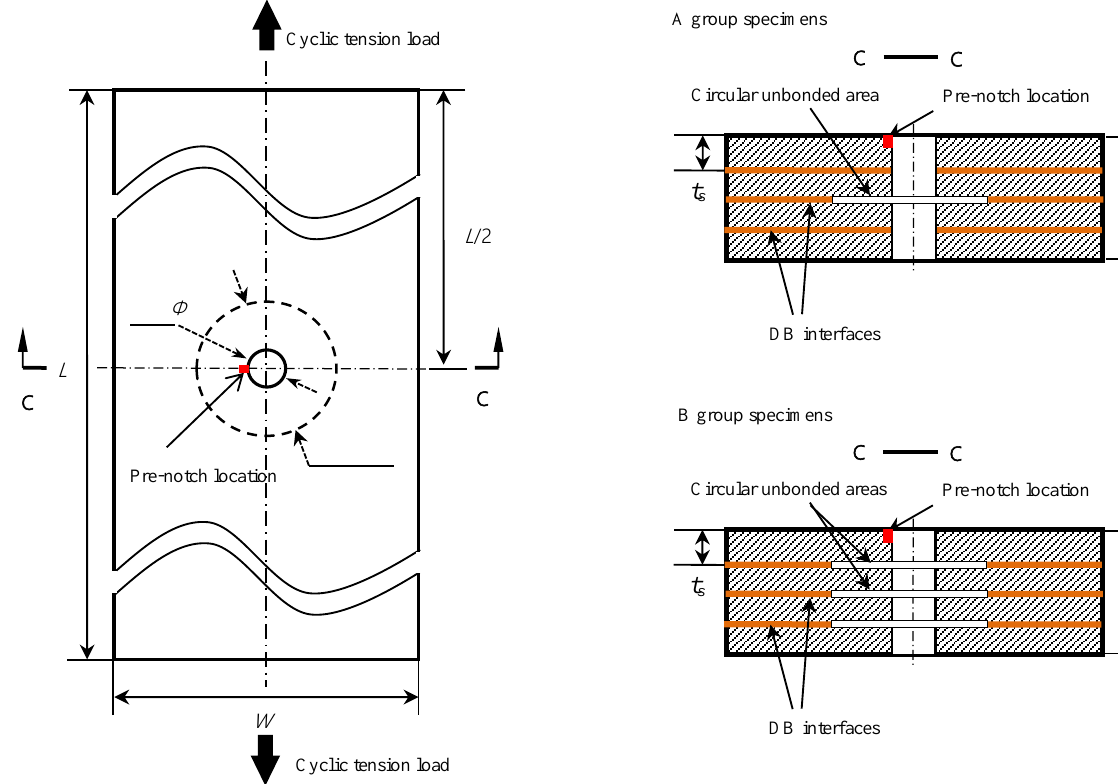
Figure 2. The layout of Groups A and B DBTALPUA specimens.